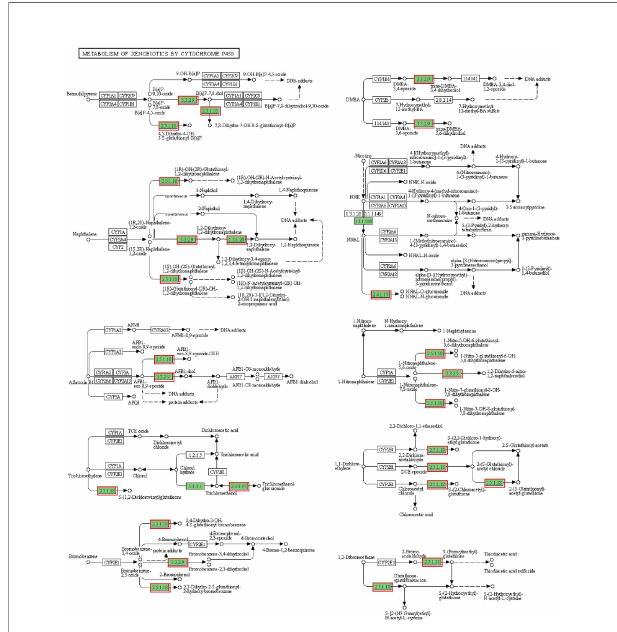
FIGURE 4 | Metabolism of xenobiotics by cytochrome P450 pathway. The annotated enzyme is marked green. Enzymes in the red box are associated with up-regulated